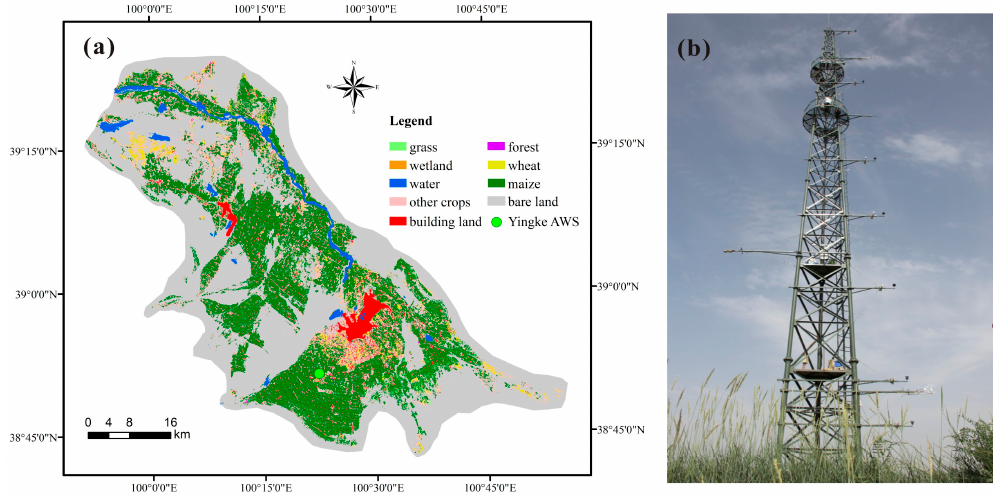
Figure 1 . ( a ) Land cover map of the middle reach of the Heihe River Basin in 2014; and ( b ) photograph of the automatic weather station (AWS) tower in Yingke.